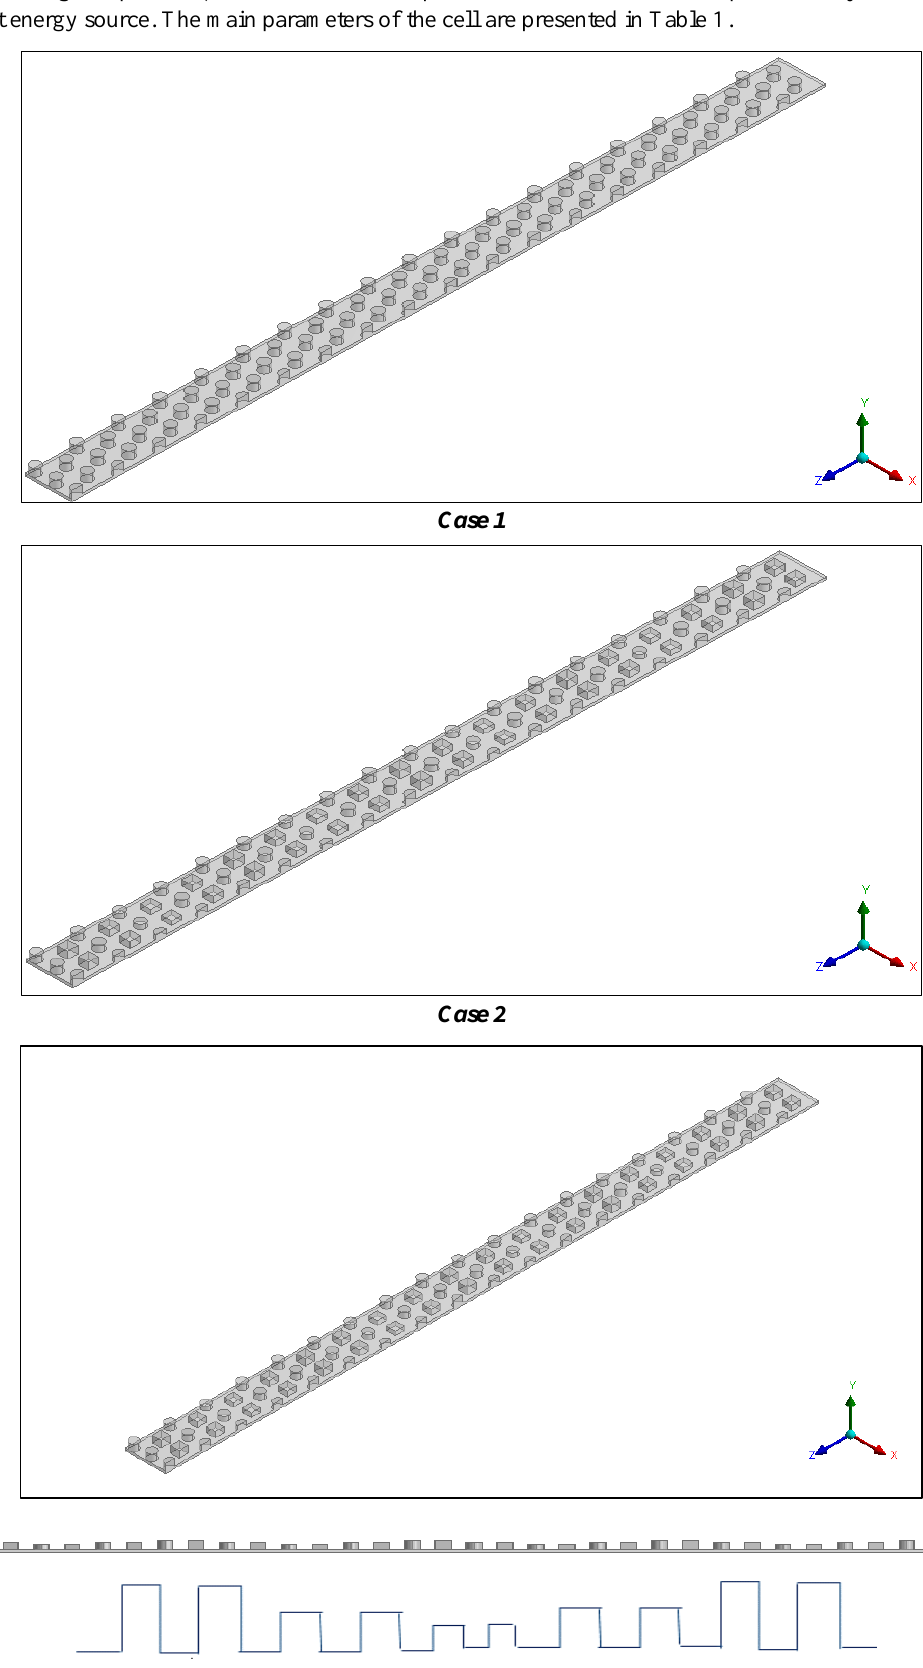
reverse flow during computation, (2) the heat sink: coupled to the air channel at the top and battery at its bottom, (3) the cell: the heat energy source. The main parameters of the cell are presented in Table